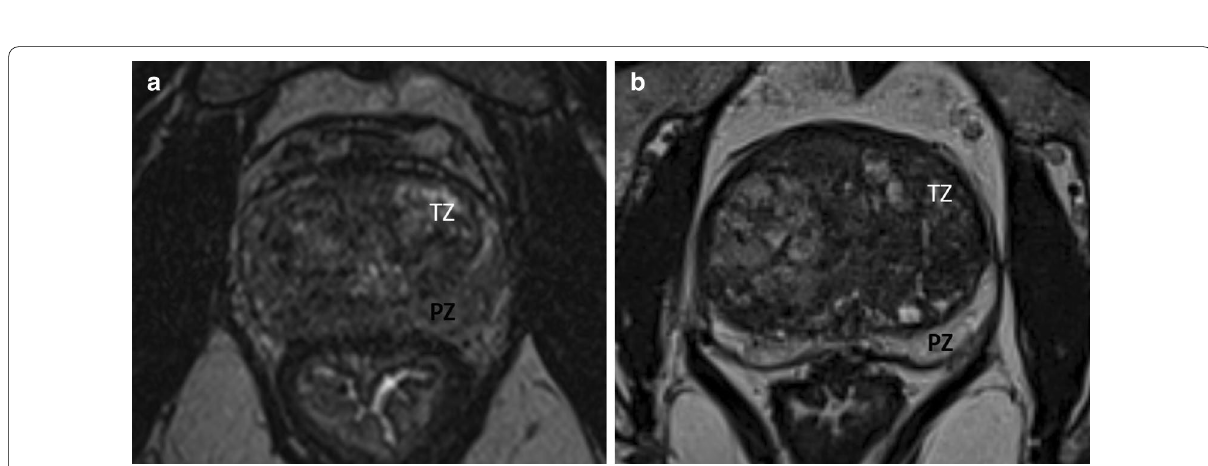
Fig. 5 Influence of intensity signal ratio between the TZ and the PZ on zonal differentiation, a Moderate signal difference between zones (signal ratio 0.98); b Marked difference in signal intensity, facilitating zonal differenciation (signal ratio =